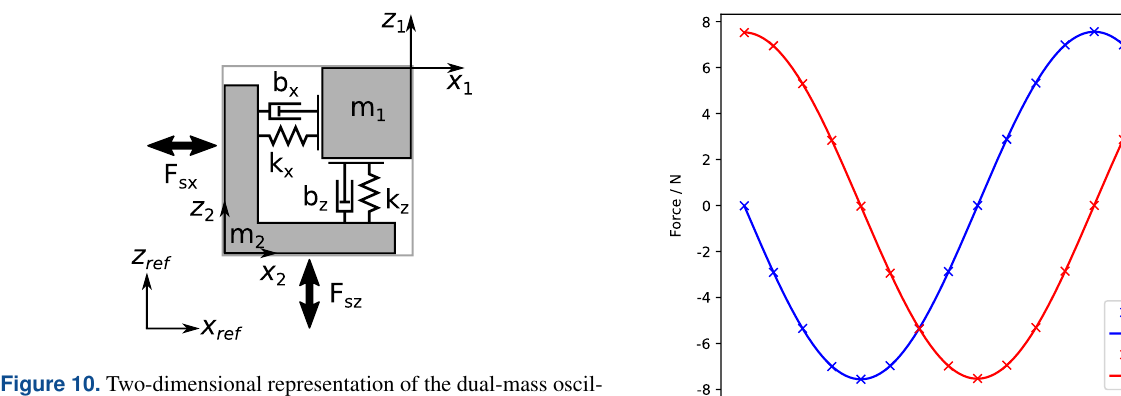
mass is calculated according to Eq. (7) to m L x = 6 . 962 and m L y = 6 . 951 kg, which differ by 0 . 028 % and − 0 . 139 %